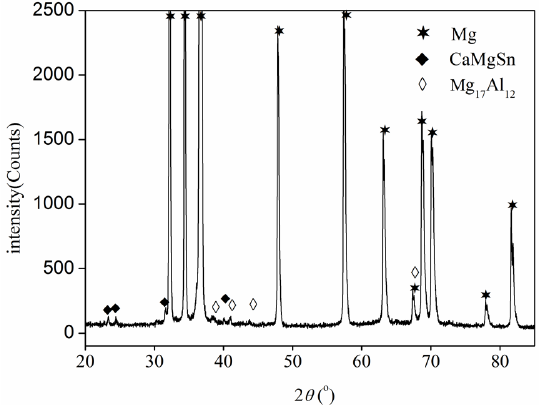
Figure 4. The XRD diffraction pattern of AZ31-0.75%CaMgSn alloy.